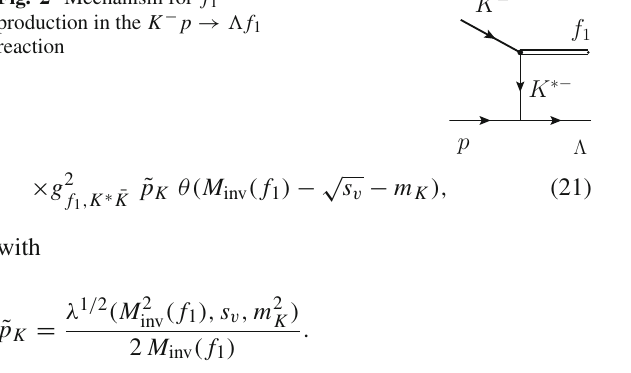
Fig. 2 Mechanism for f 1 production in the K − p → (cid:4) f 1 reaction